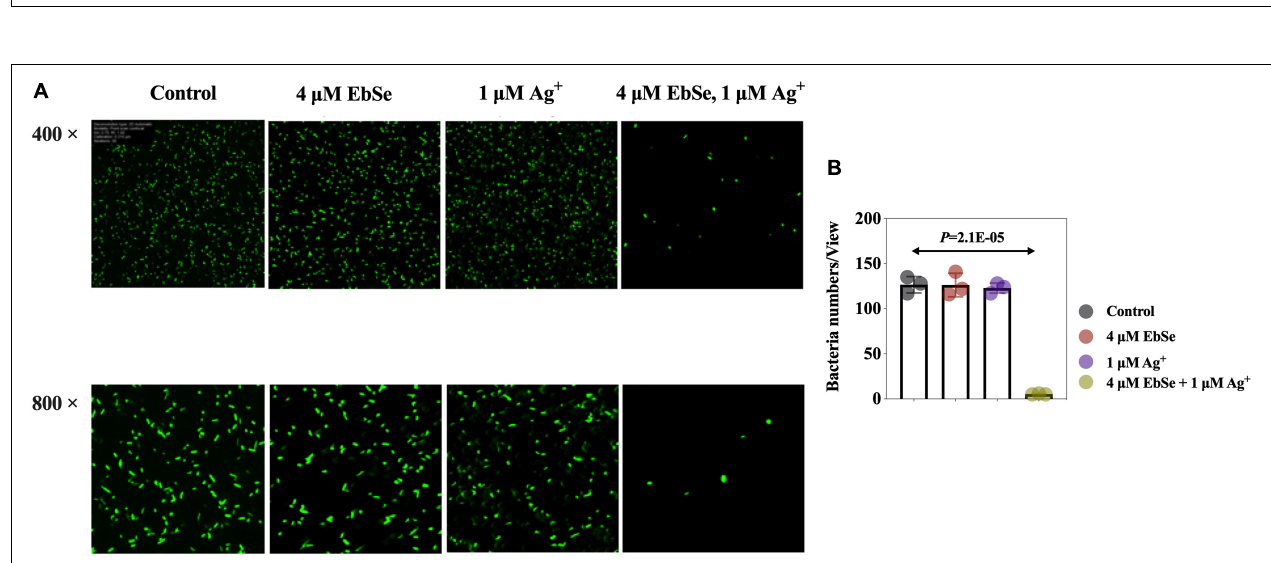
FIGURE 2 | EbSe-Ag + has a bactericidal effect against YpIII. YpIII-GFP were cultured to A 600 of 0.4, diluted 1:1,000 times, and treated with either EbSe, Ag + or EbSe-Ag + . (A) LSCM results showed EbSe-Ag + has a bactericidal effect against YPIII-GFP; (B) quantitative values.